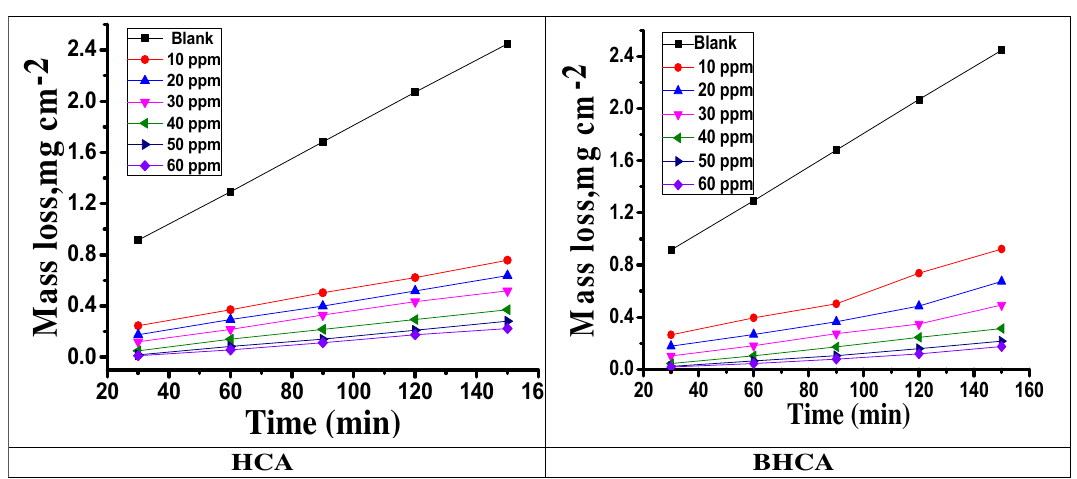
Figure 3. ML-time curves of CS with and without various concentrations of HCA and BHCA in 1 M